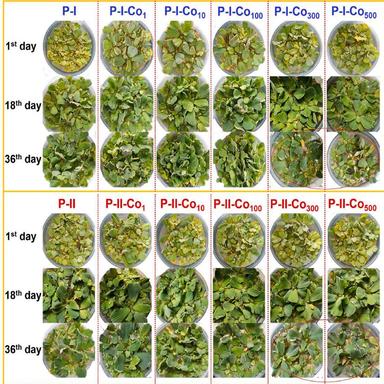
Digital photos of Pistia stratiotes in different culture solutions and different intervals.